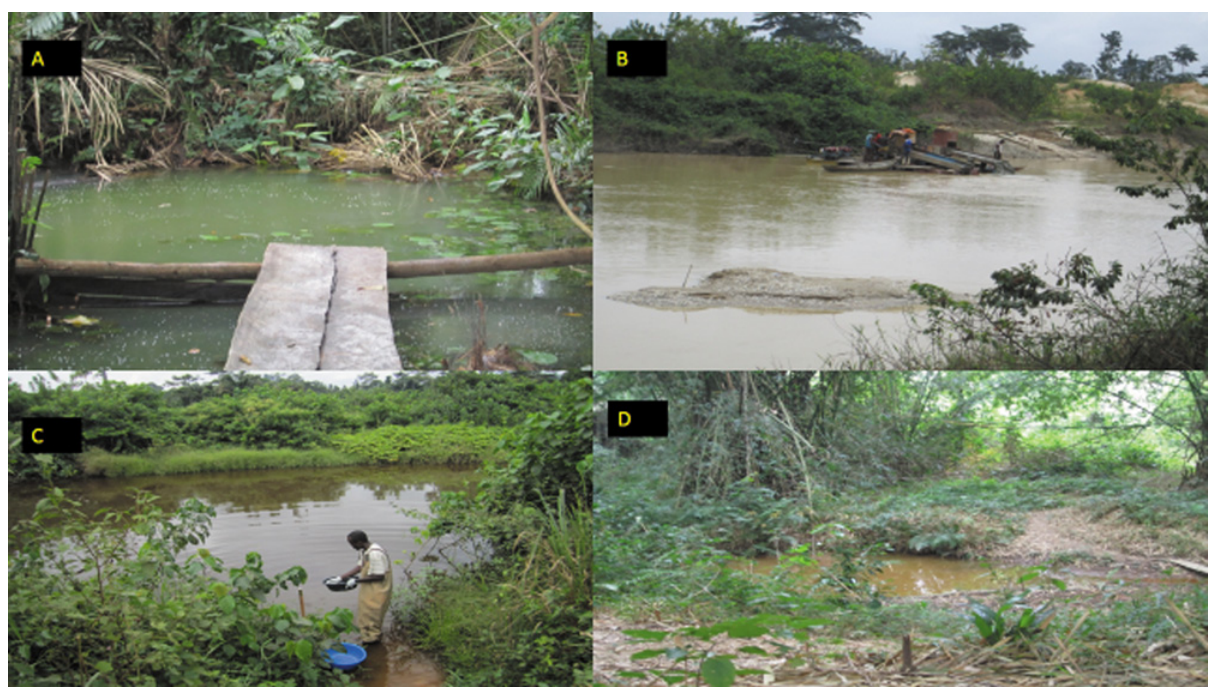
Figure 1. Four water bodies that were sampled. A) Twingun 2 pond at Sukuumu; B) illegal mining activities (galamsey) on the Offin River at Monia- Gyaman; C) Nkotia stream at Sukuumu; D) Bebonu pond at Wromanso.